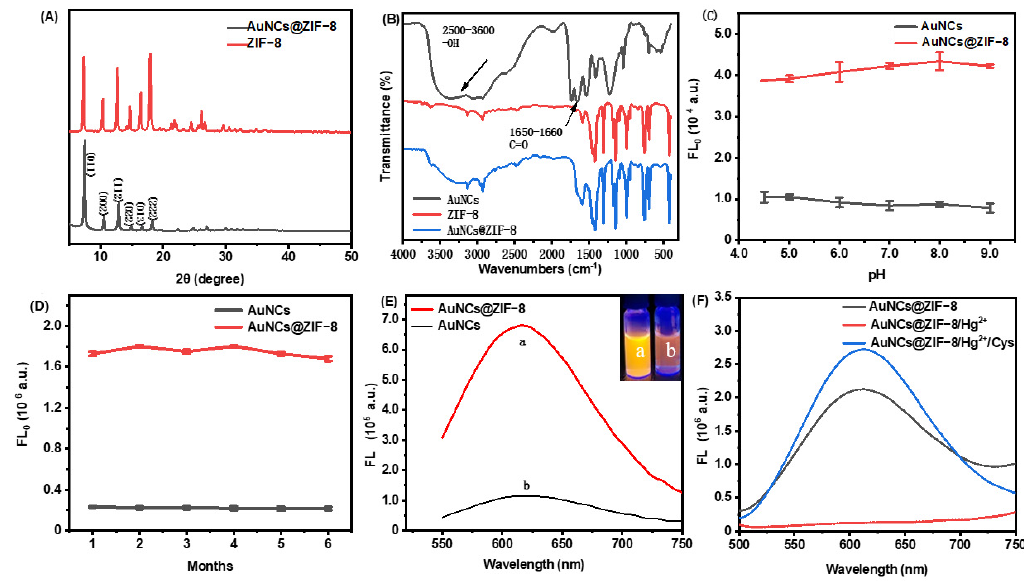
Figure 2. Basic properties of ZIF-8 and AuNCs@ZIF-8 MOFs. ( A ) XRD pattern, ( B ) FT-IR spectra, effect of pH ( C ) and time ( D ) on material stability, ( E ) fluorescence emission spectra containing same concentration of AuNCs. ( F ) The fluorescence emission spectra of AuNCs@ZIF-8, AuNCs@ZIF-8/Hg 2+ and AuNCs@ZIF-8/Hg 2+ /Cys.